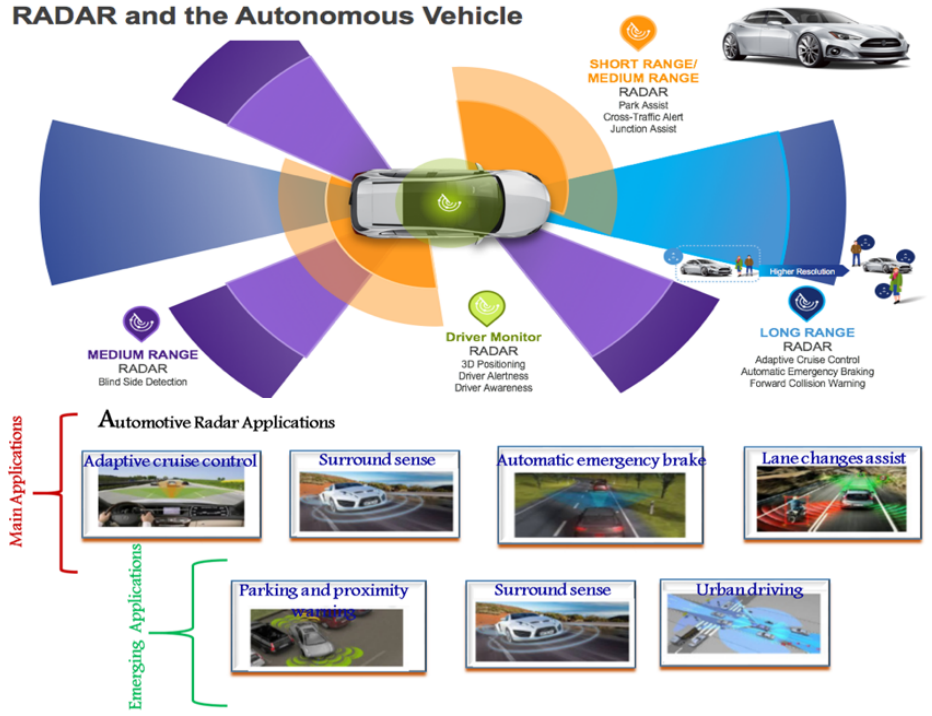
Figure 2. Automotive radar